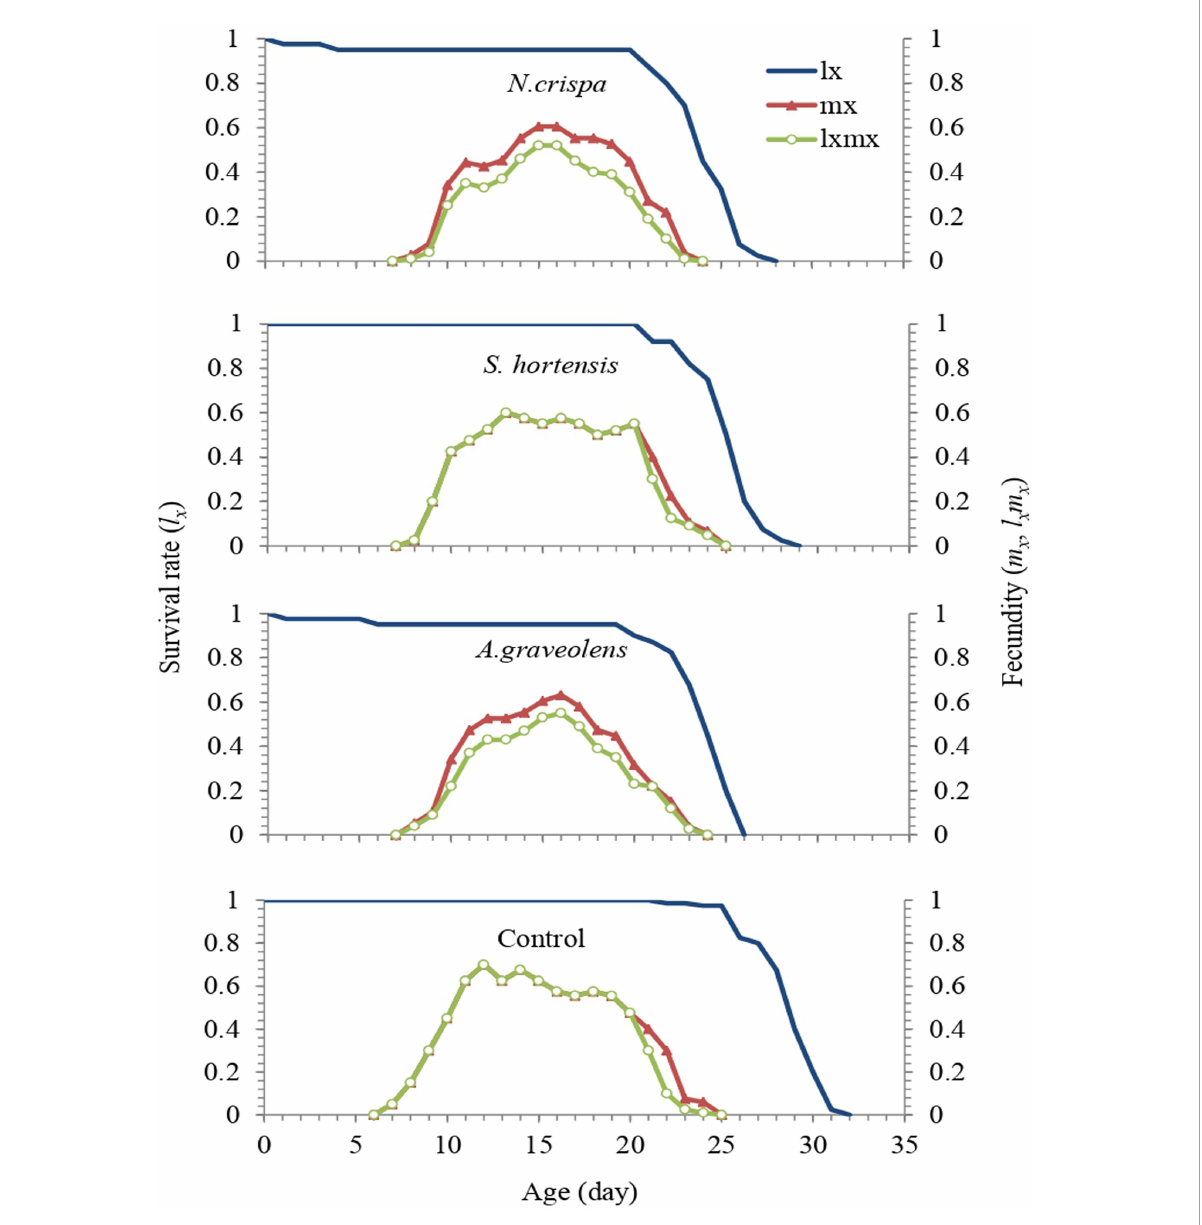
FIGURE4 Age-specific survival ( l x ) and age-specific fecundity ( m x ) of the population of A. swirskii females from control and treatments of N. crispa , S. hortensis , and A. graveolens